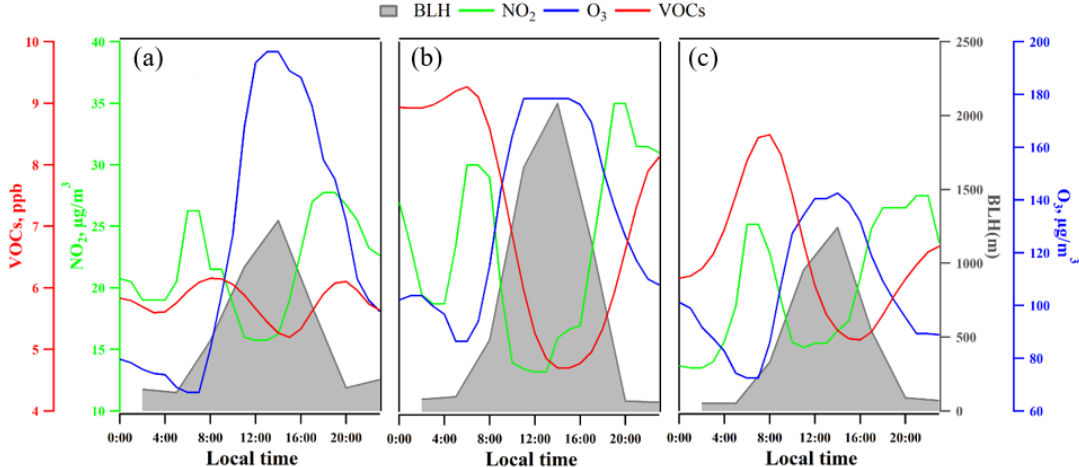
Figure 5. Diurnal variation in boundary layer height (BLH), VOC, NO 2 and O 3 concentrations on different control phases: phase ( a ), phase ( b ) and phase ( c ).